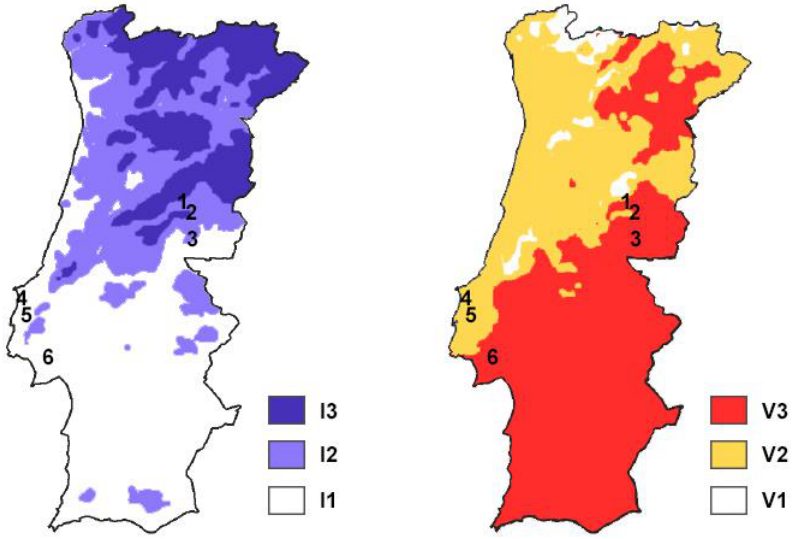
Figure 2. Portuguese climate severities in winter (I) and summer (V) seasons for each building location: Covilhã (1), Fundão (2), Castelo Branco (3), Lourinhã (4), Torres Vedras (5), Moita (6) location: Covilh ã (1), Fund ã o (2), Castelo Branco (3), Lourinh ã (4), Torres Vedras (5), Moita (6) (adapted from [28]). (adapted from